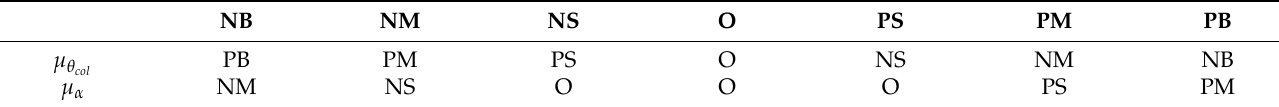
Figure 3. The membership function plots.